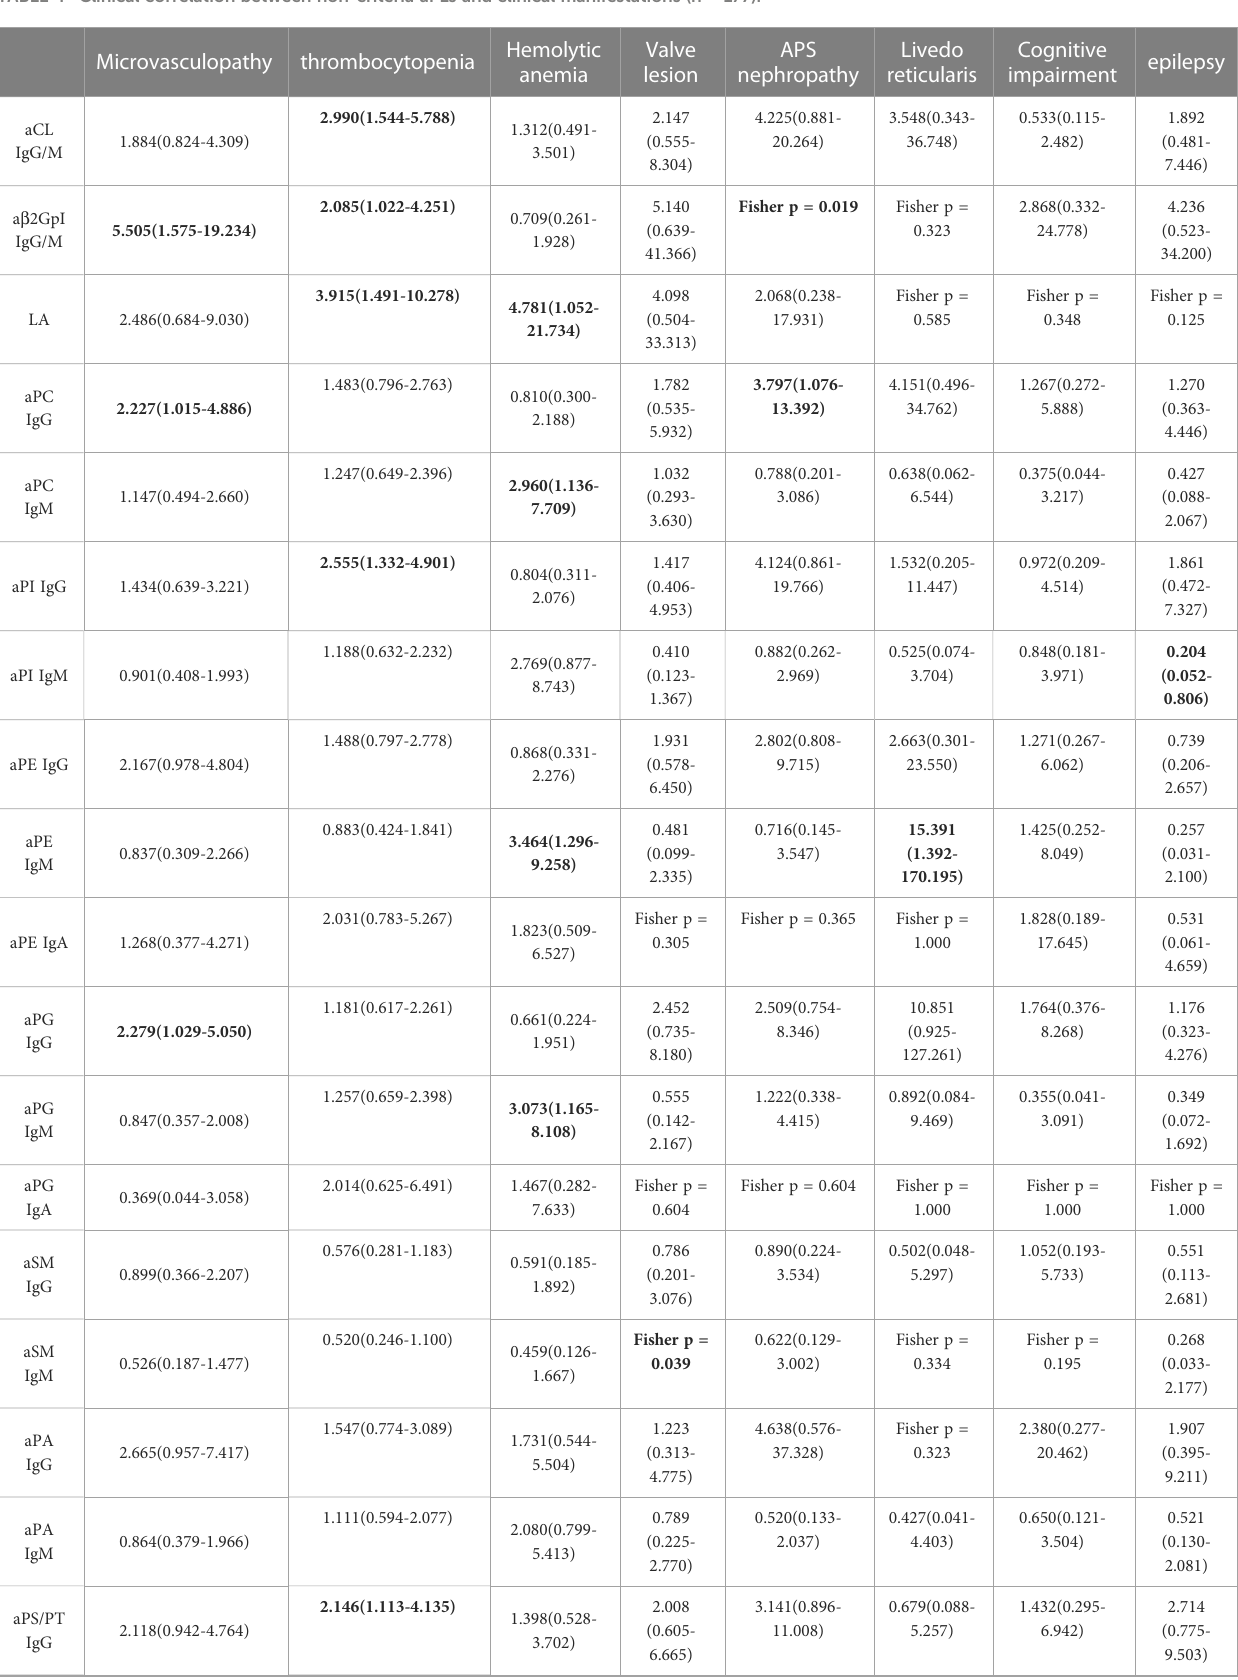
TABLE 4 Clinical correlation between non-criteria aPLs and clinical manifestations (n =